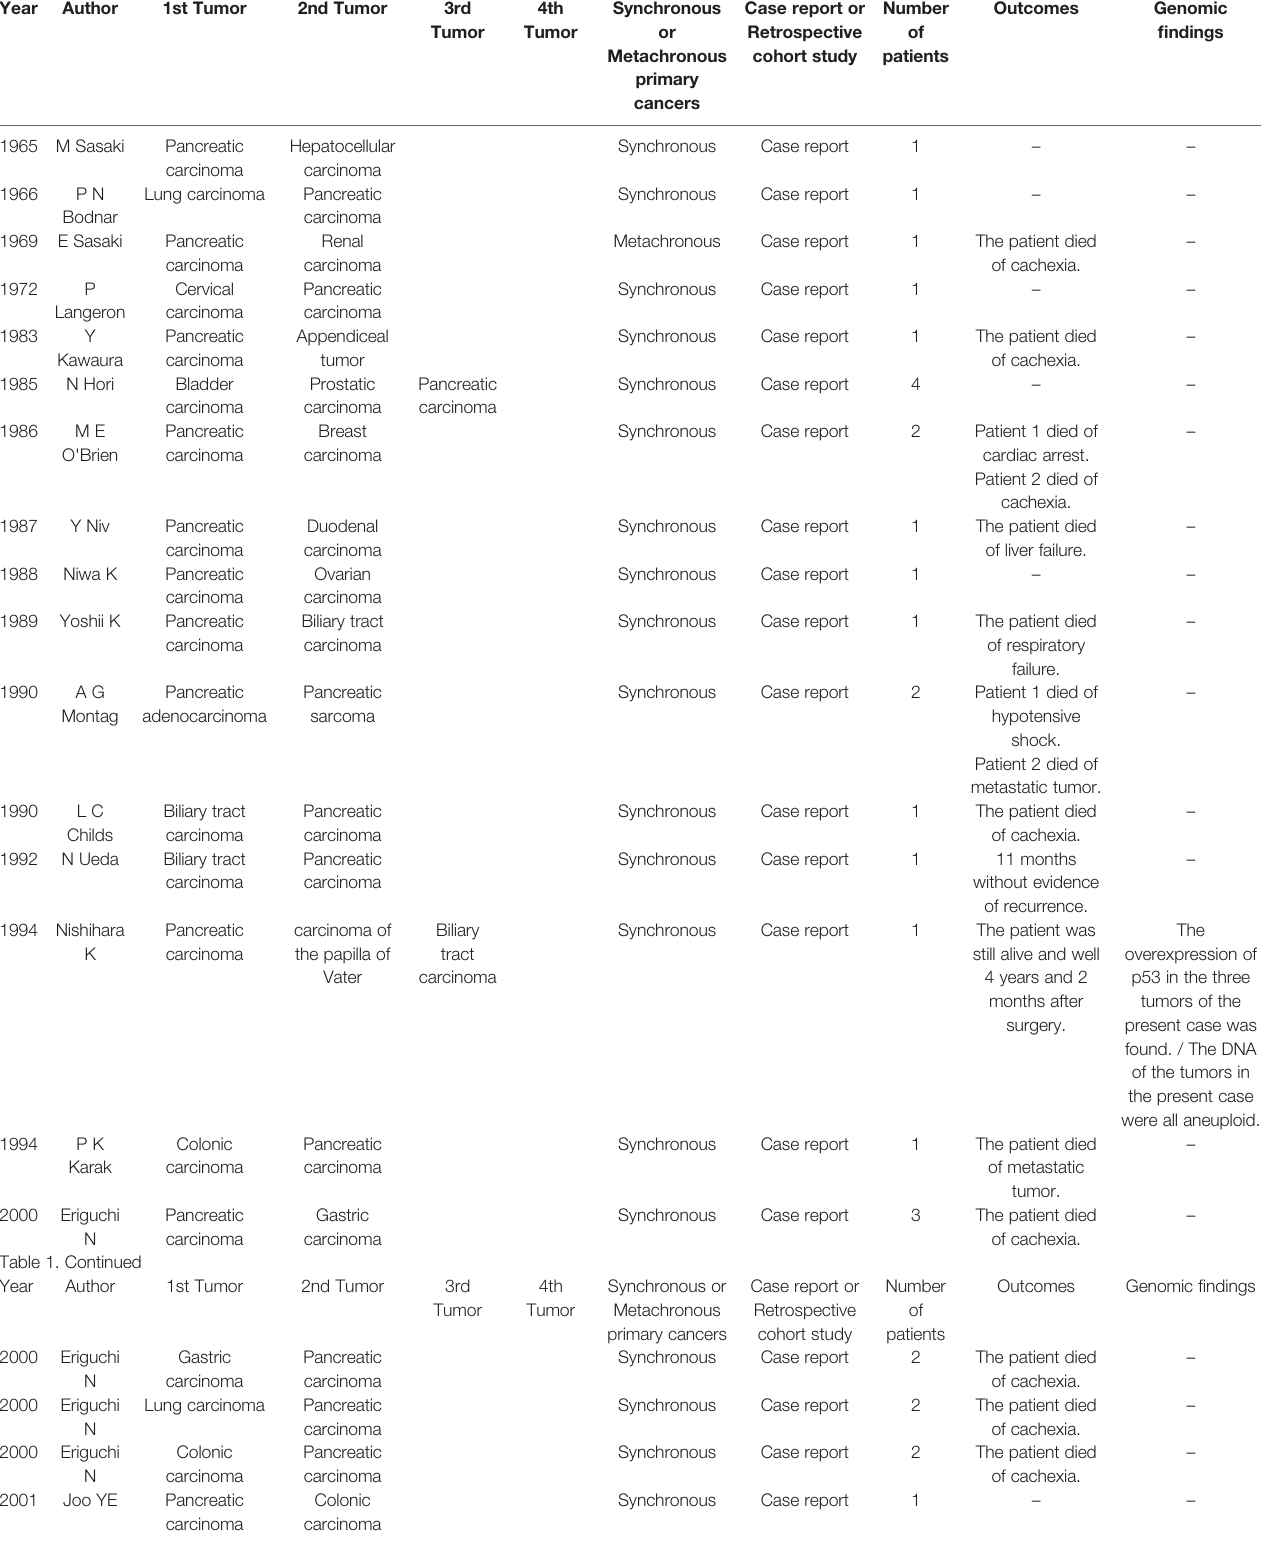
TABLE 1 | Summary of the previous studies describing multiple primary malignant neoplasms with pancreatic